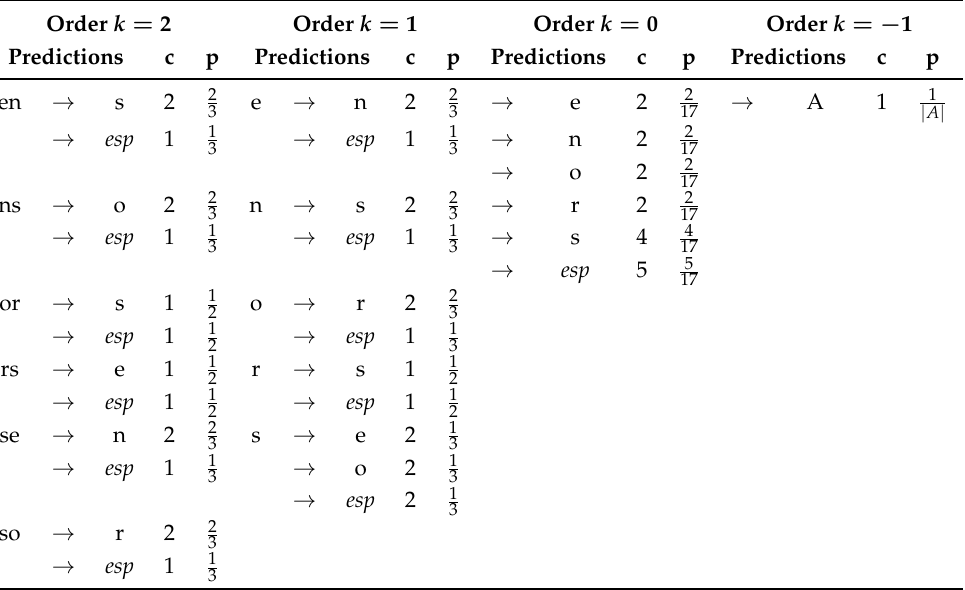
Table 2. PPM model after processing input string ‘ sensorsensor